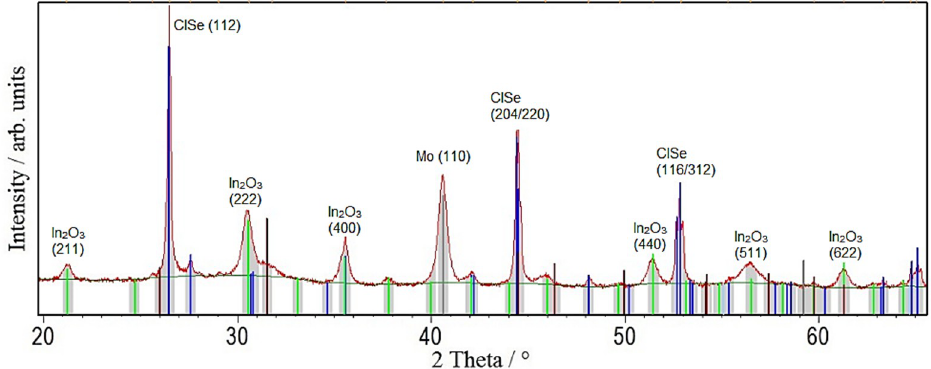
Figure 6. XRD pattern of a CISe‐film from Cu 2− x Se + In 2 Se 3 nanoparticle precursor after the repetition of coating and annealing at 550 °C for 5 min shows huge amounts of In 2 O 3 in the film.